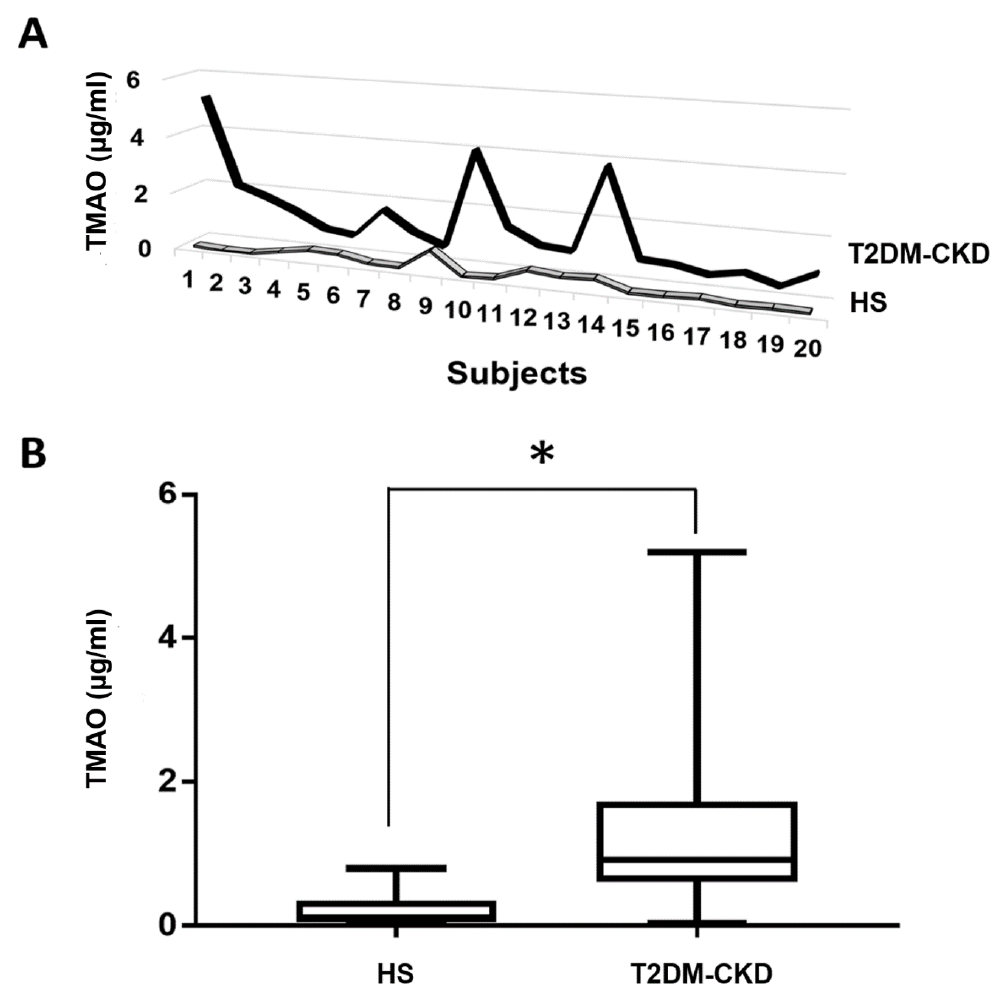
Figure 2. Serum TMAO concentrations in T2DM-CKD and healthy subjects (HS). ( A ) comparison between serum TMAO measurements in T2DM-CKD and healthy groups; ( B ) median (min–max) measurements of serum TMAO ( µ g/mL) in healthy individuals ( n = 20) and patients ( n = 20). Mann– Whitney U test was used to compare TMAO measurements in both groups. * p < 0.05.